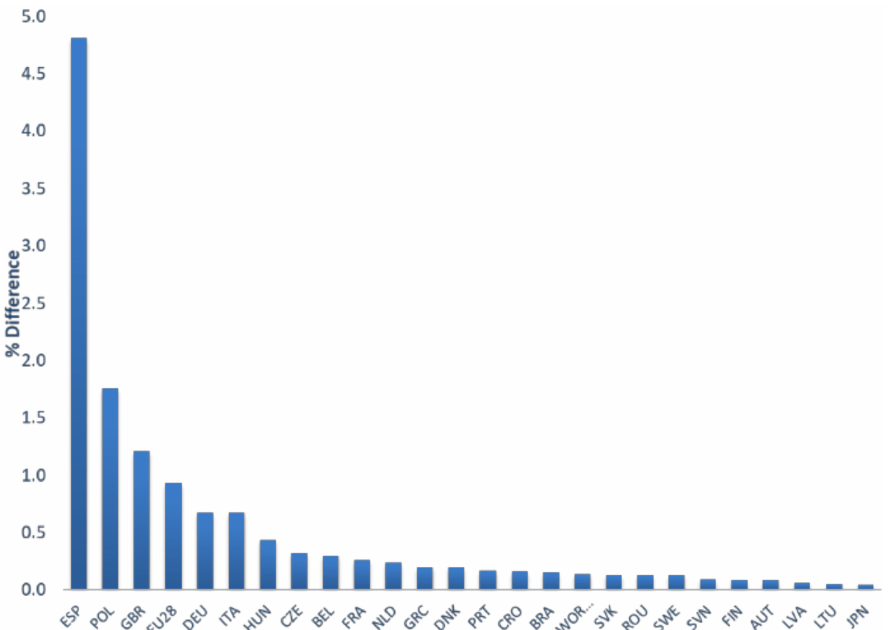
Figure 7. GDP Changes in 2DEG_PRD in 2050 (% di ff erence from 2DEG).